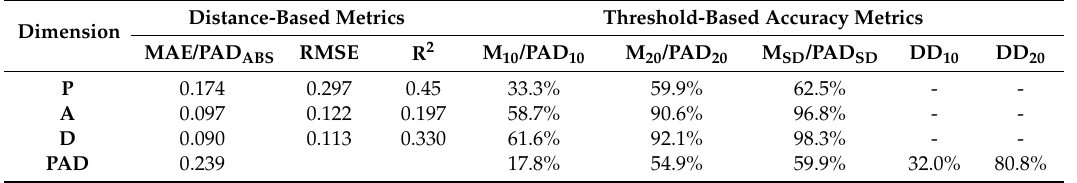
Table 8. Accuracy metrics for the new mapping for the SYNE-ANEW dataset (cross-validation results). Distance-Based Metrics Dimension